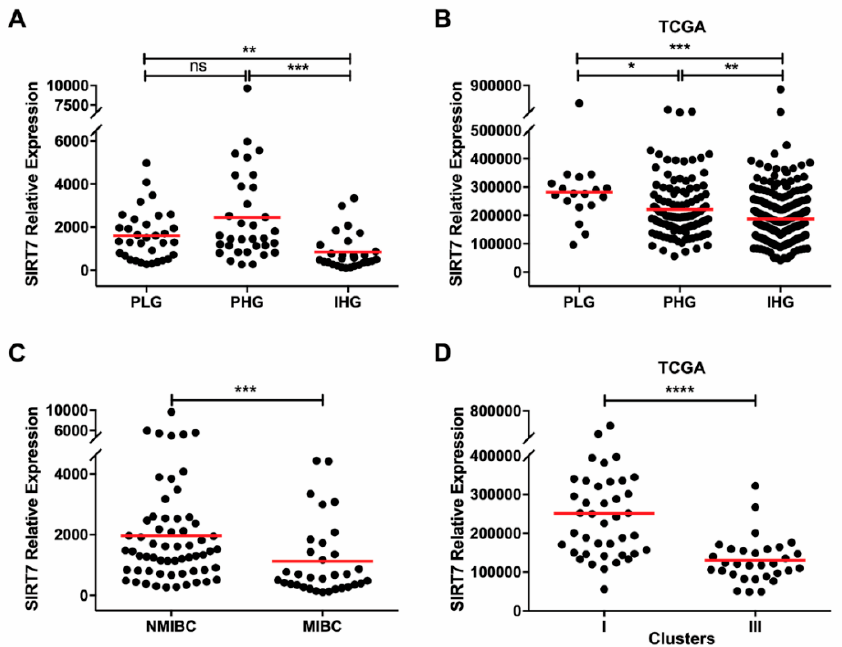
Figure 2. Figure 2. Cont. Figure 2. Cont.